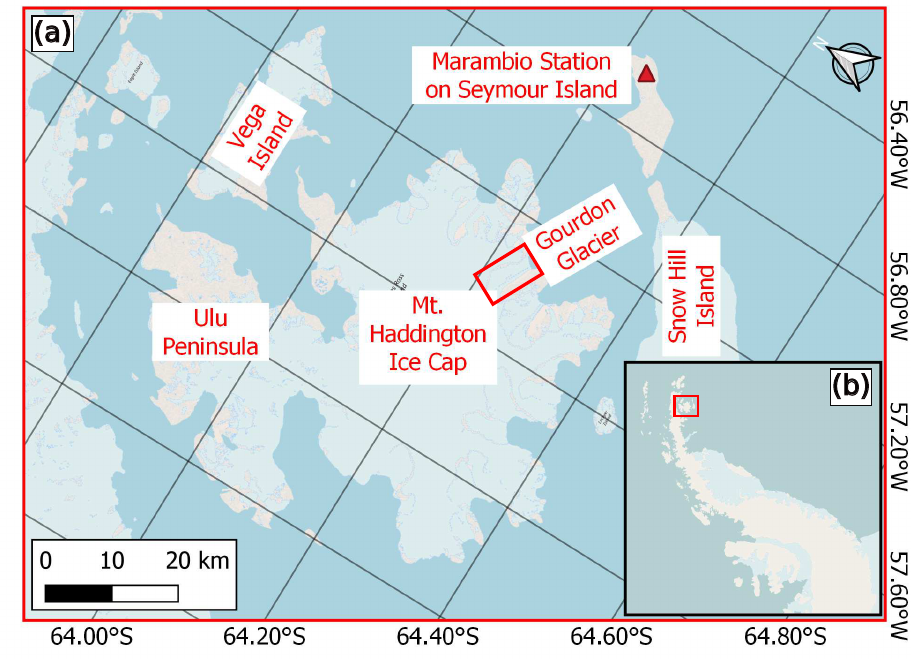
Figure 1. ( a ) Map of JRI with the Ulu Peninsula on the left, Mt. Haddington at the central part, and Gourdon Glacier on the eastern side, as well as the adjacent islands. ( b ) Overview map with the marked location (red rectangle) of JRI at the northern Antarctic Peninsula. c (cid:13) OpenStreetMap